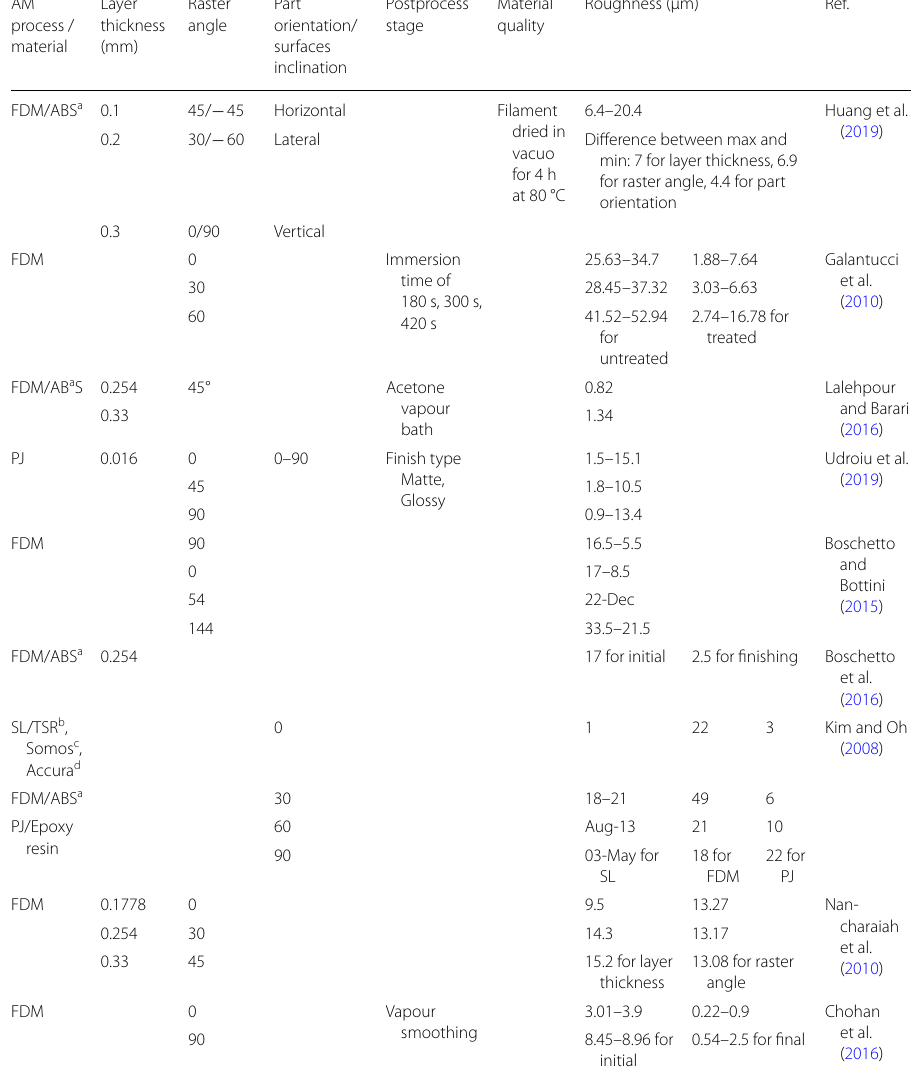
Table 2 Influential AM parameters on surface